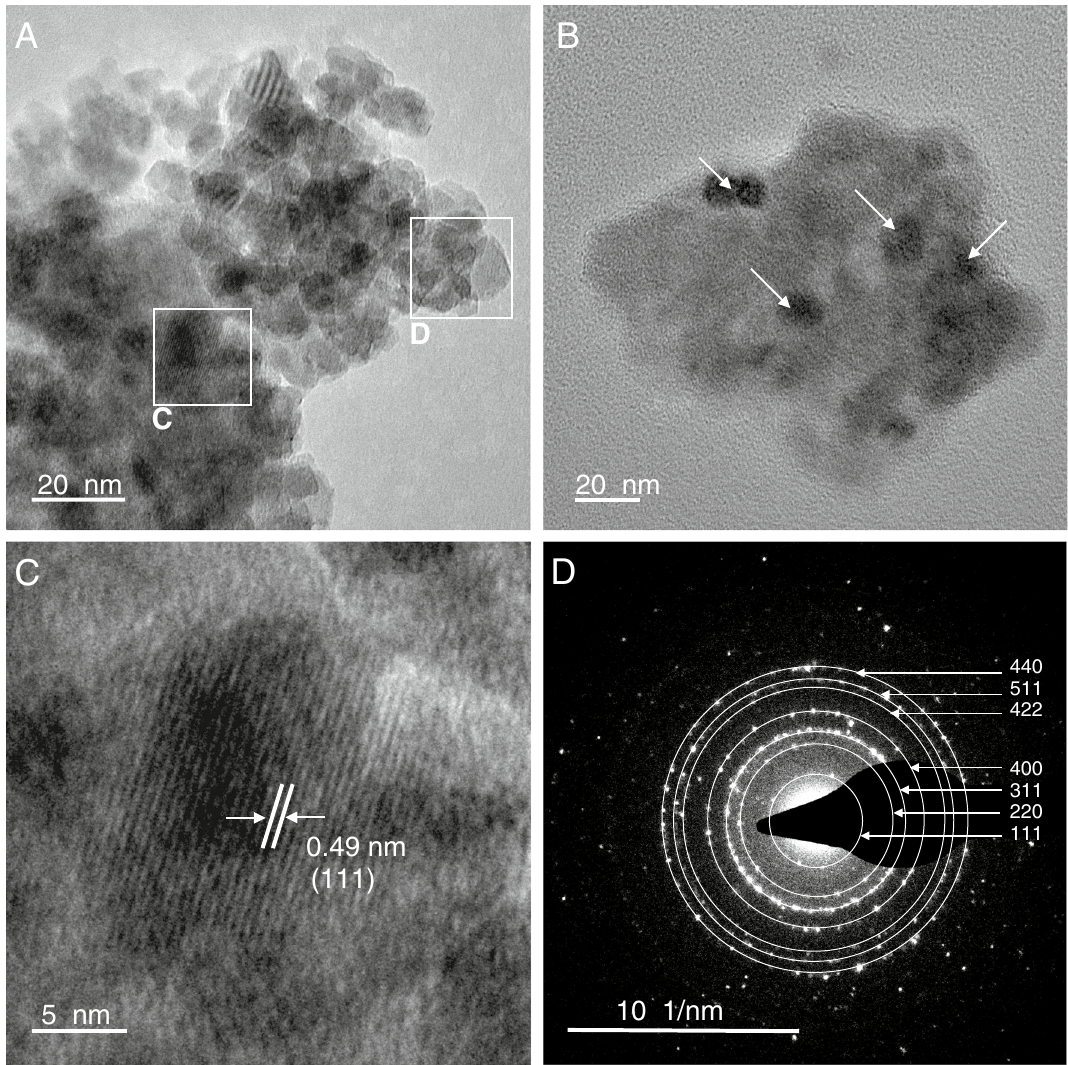
Figure 3. TEM analysis of London Underground sample 180487-86: ( A ) HRTEM image showing aggregates of magnetic nanoparticles, ( B ) darker particles represent individual particles oriented to give strong diffraction contrast ( C ) high- magnification image showing d-spacing for 111 planes of magnetite, ( D ) the selected area diffraction (SAED) pattern from region d shows randomly oriented magnetite